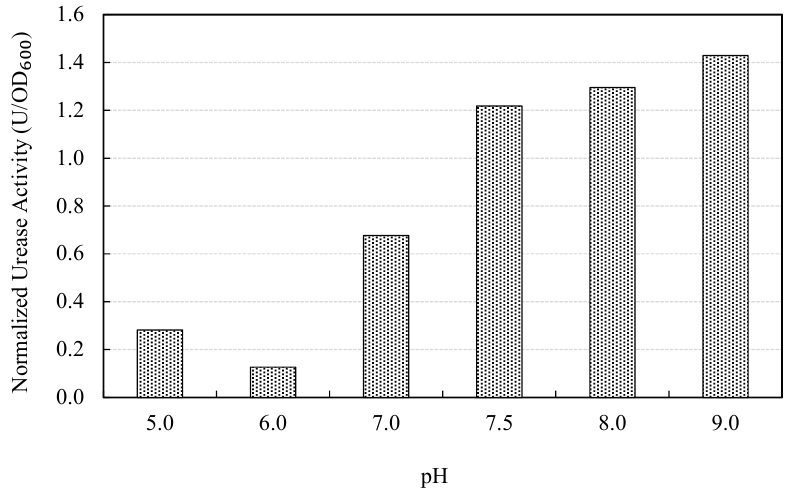
Figure 6. Variation of urease activity of Sporosarcina sp. at different pH conditions.